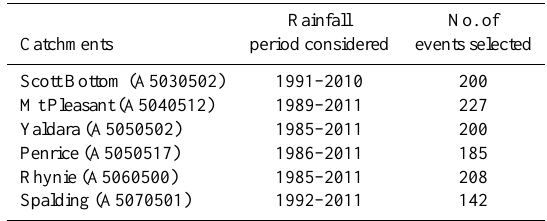
Table 3. Selected rainfall